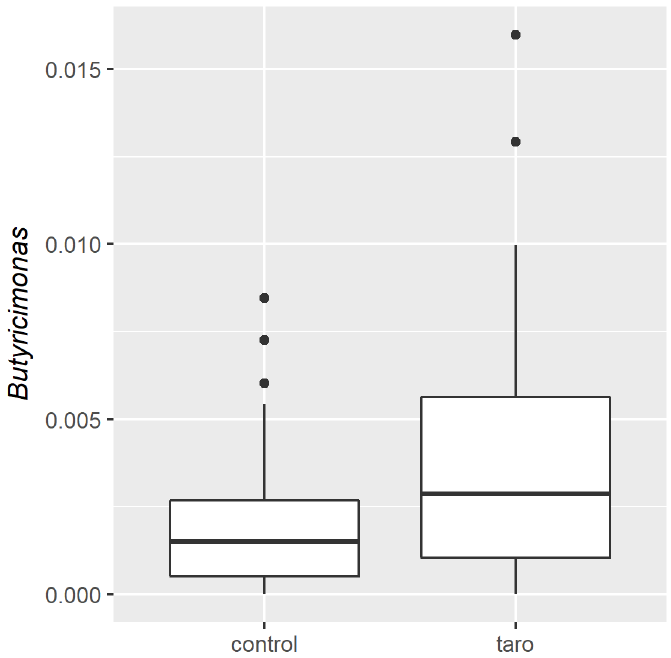
Figure 2. Difference in Butyricimonas between the control (including four baseline samples and the end sample after control intervention) and taro feeding (end samples after taro, taro + probiotic, and taro + beetroot).